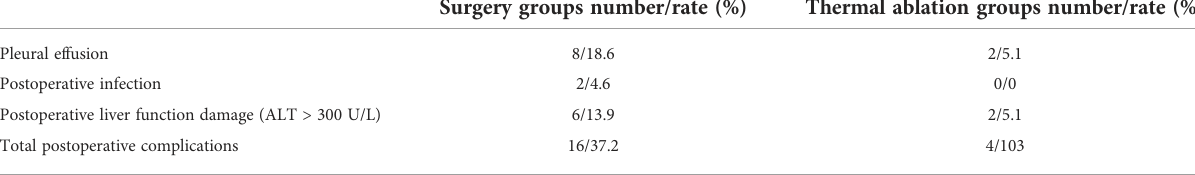
TABLE 4 Comparison of postoperative complications between the two groups.